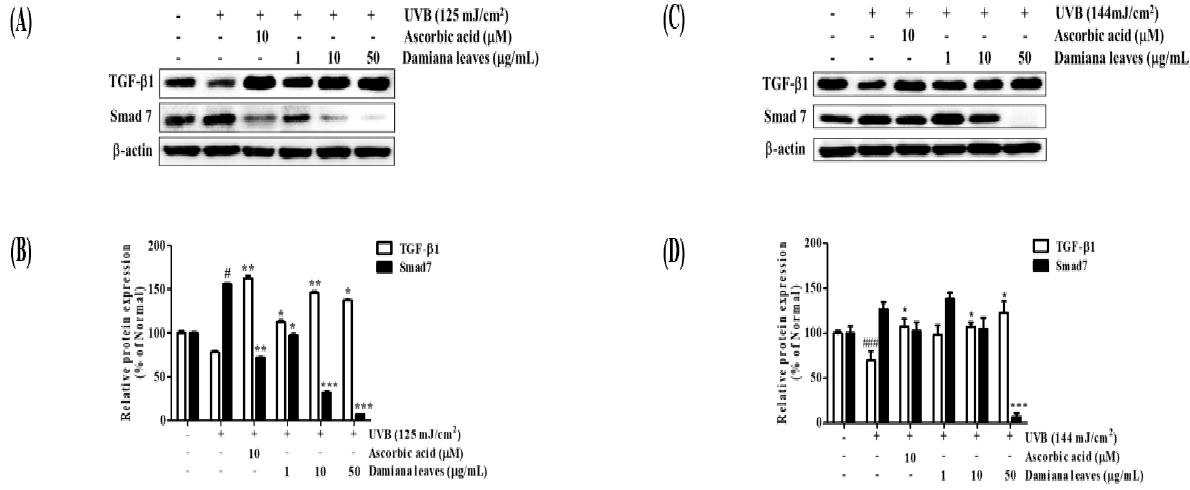
Figure 8. Effect of Damiana leaves extract on protein expression TGF- β 1/Smad7 signaling pathway on UVB-irradiated HaCaT ( A , B ) and HDF ( C , D ) cells. Data are presented as the mean ± SD. # and * indicate significant differences from the non-irradiated control and UVB-treated groups, respectively. # and ### p < 0.05 and 0.001 vs. the non-treated group. *, ** and *** p < 0.05, 0.01, and 0.001 vs. the UVB-treated control, respectively.